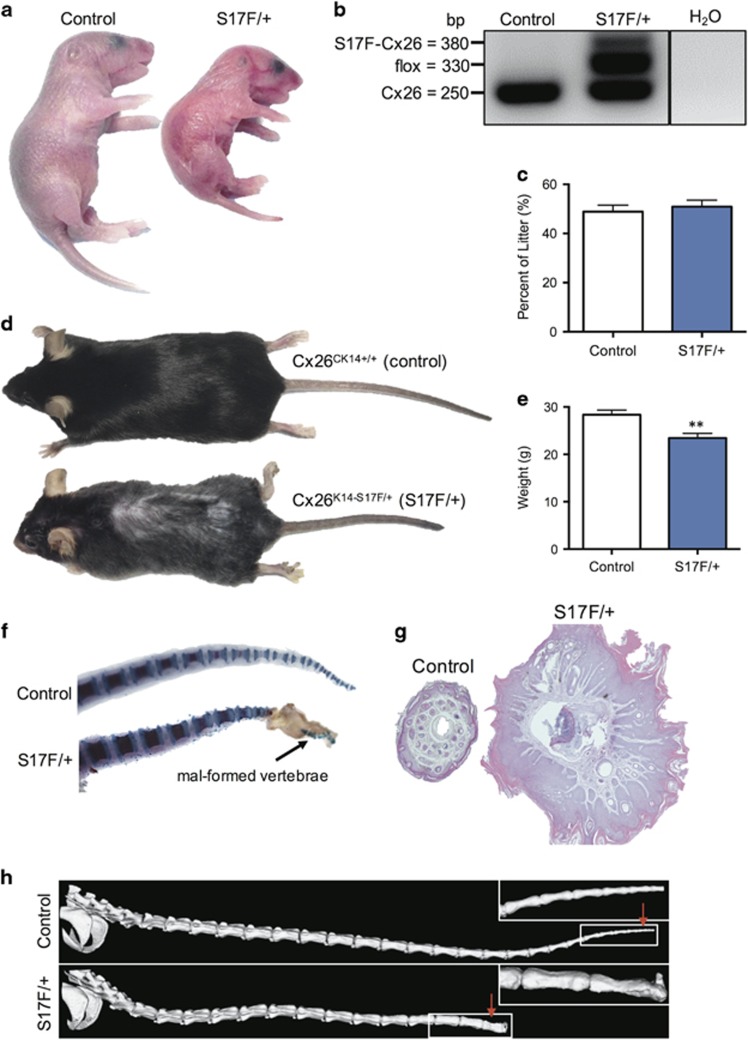
S17F/+ mice mimic KIDS skin characteristics and have several additional phenotypes. (a) S17F/+ neonates were smaller and visually distinguishable from control littermates. (b) Skin sample PCR amplification confirms the heterozygous expression of Cx26S17F in S17F/+ mice. (c) Litters contained equal portions of S17F/+ and control pups with no loss of mouse viability (unpaired t-test, Control: n=157, S17F/+: n=148). (d) Representative photos of 3-month-old S17F/+ and control mice reveal moderate differences in size but a pronounced tail phenotype. (e) Whole mouse weights at 3 months of age showed S17F/+ mice were ~15% smaller (unpaired t-test, **P<0.01, N=17). (f) Skeletal stains of P7 tails revealed vertebral malformations underlying the tail phenotype in S17F/+ mice. (g) Cross-section of a distal tail paraffin section stained with hematoxylin and eosin revealed grossly thickened epidermis. (h) μCT scans of 3-month-old mouse tails revealed vertebral abnormalities in S17F/+ mice. Red arrows in (h) denote the relative locations of cross sections in (g)